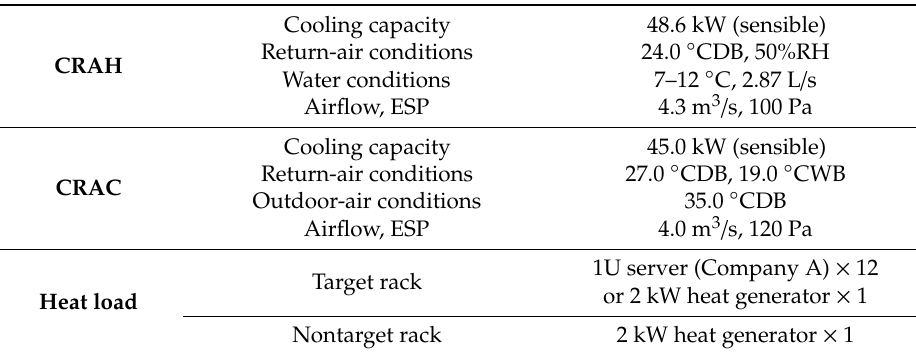
Figure 2. Full-scale experimental room: ( a ) Floor plan; ( b ) section A-A’ with cold-aisle containment (CAC); ( c ) section B-B’ with CAC; ( d ) section A-A’ with hot-aisle containment (HAC); and ( e ) section C-C’ with HAC. Table 2. Experimental facility.